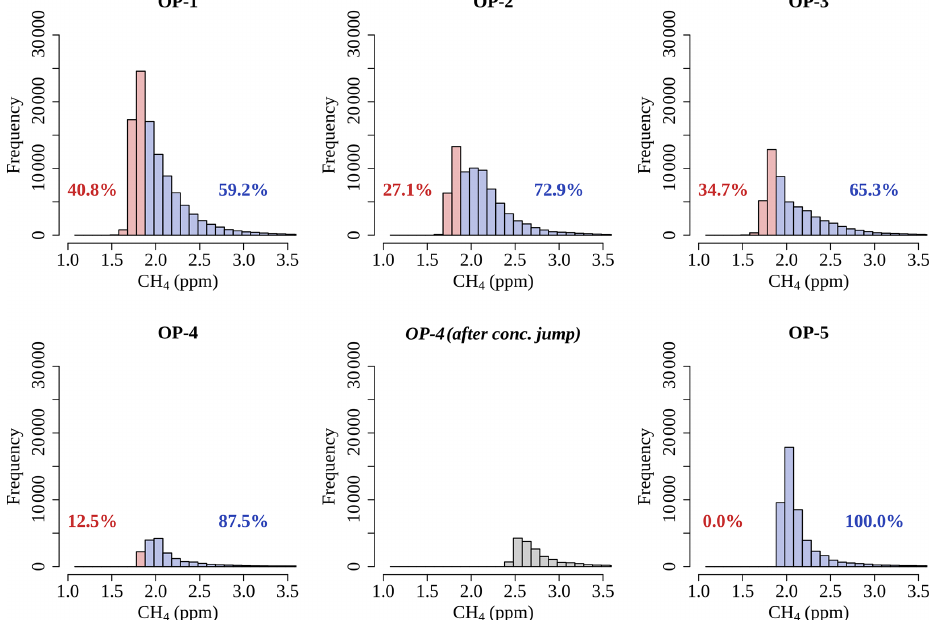
Figure 2. Histograms of recorded 1min average concentrations of GF3 devices OP-1, OP-2, OP-3, OP-4 and OP-5. A few values greater than 3.5ppm are not shown. Blue: values > 1.88ppm; red: values ≤ 1.88ppm. Grey: data from device OP-4 during the campaign H19-3 that passed the quality check but have been omitted in the analysis due to an obvious jump in the concentration (Fig. 3).